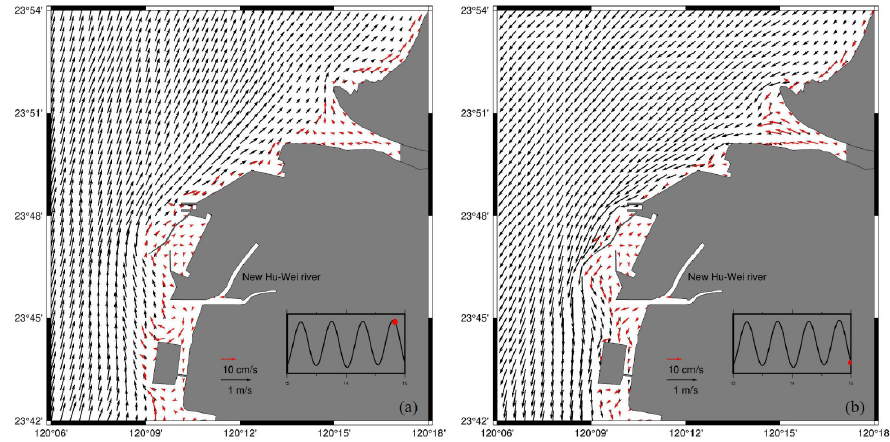
Figure 10. ( a ) Model results show that alongshore currents flow northward at approximately 80– 100 cm/s during flood tides, with an anticyclonically weak recirculation (red arrows) in the NHW estuary. ( b ) The tidal current (100 cm/s) along the west coast of the Mailiao industrial zone flows southward during ebb tides with weak southward currents in the NHW estuary. Note that the black and red arrows have different scale bars.